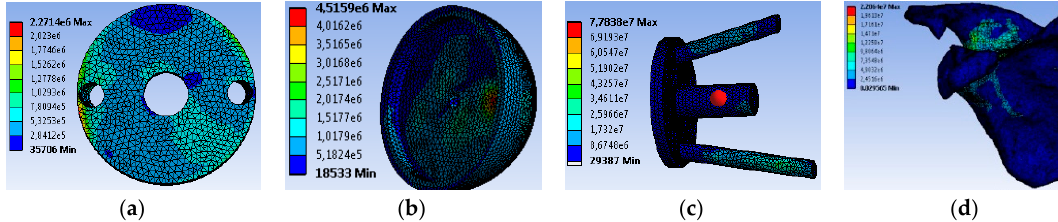
Figure 9. The distribution of Von Mises stresses in the cases of: ( a ) Graft, ( b ) glenosphere, ( c ) support with screws and ( d ) scapula.